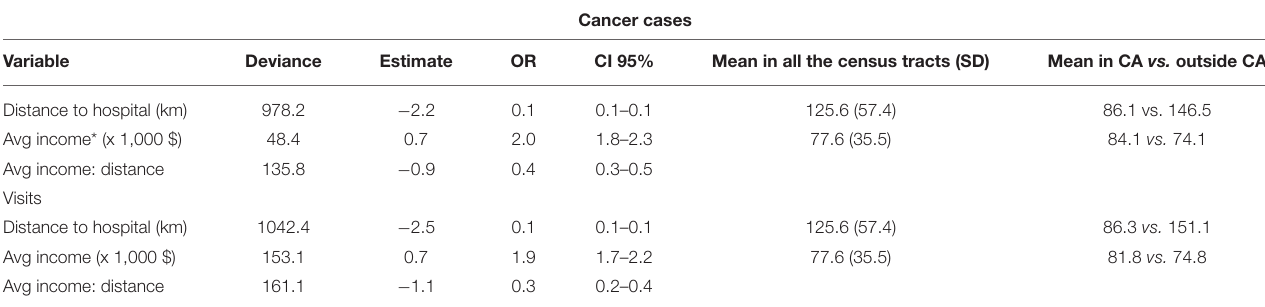
TABLE 2 | Results of the logistic regression to analyze the associations between distance to hospital and average household income with the inclusion in the catchment area (CA) estimation for cancer cases and visits. Cancer cases Variable Deviance Estimate OR CI 95% Mean in all the census tracts (SD) Mean in CA vs. outside CA